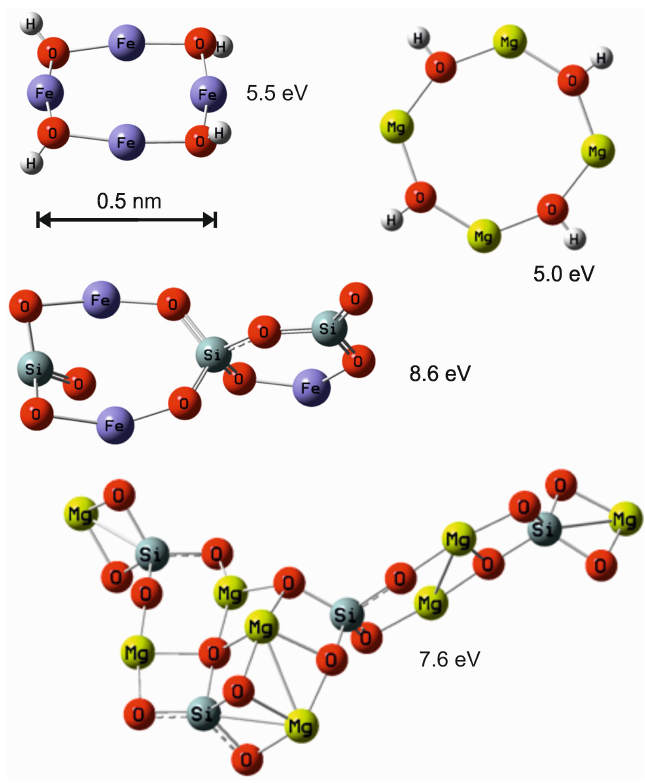
Fig. 10. Optimised geometries of possible embryonic meteoric smoke particles: (FeOH)4, (MgOH)4, (FeSiO3)3 and (Mg2SiO4)4. The vertical ionization potentials are shown alongside each cluster.